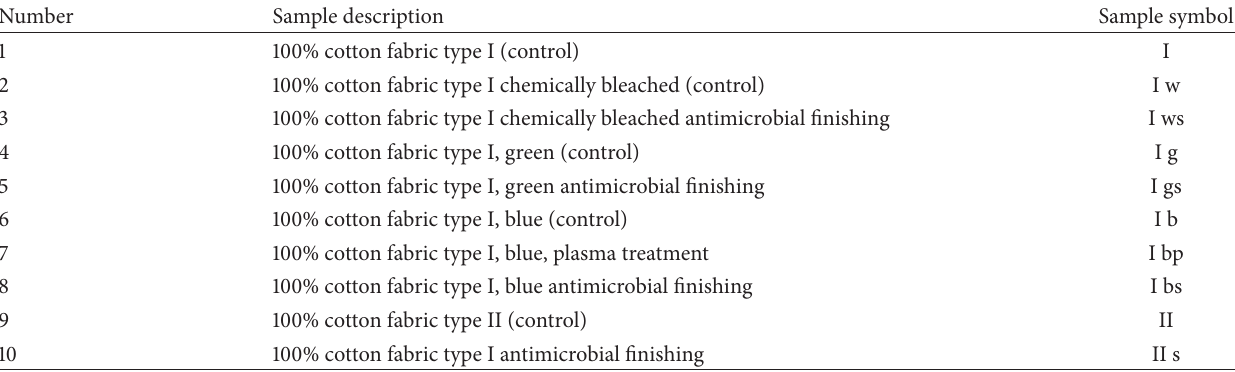
Table 1: 100% cotton fabric samples obtained and analyzed in the paper.